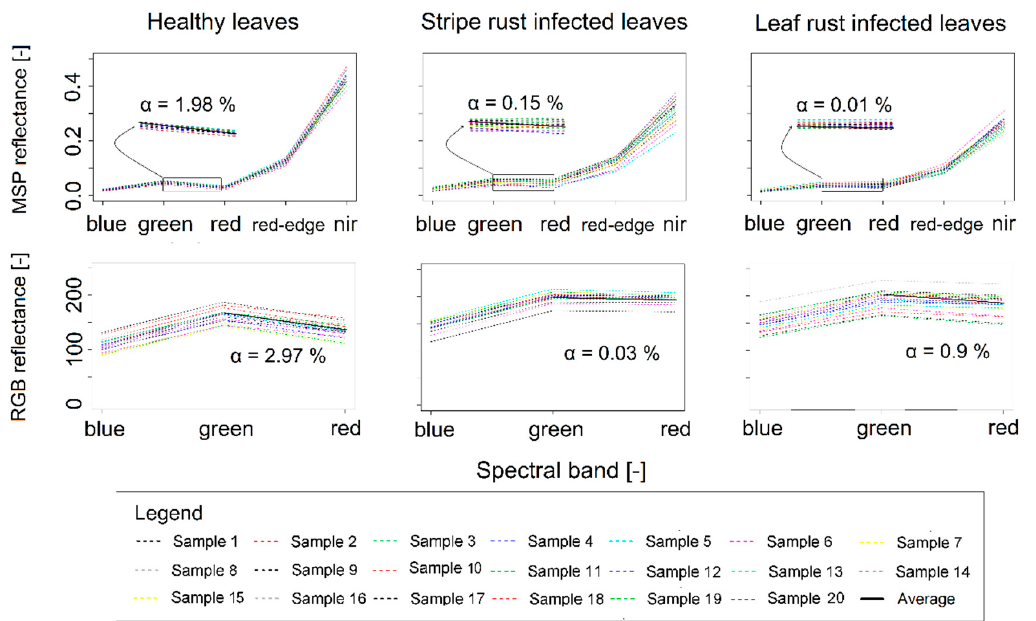
Figure 9. Reflectance spectra generated for healthy ( left ), stripe rust ( middle ), and wheat leaf rust ( right ) infected wheat samples derived from multispectral (MSP; top ) and Red-Green-Blue (RGB; bottom) sensors. Samples were selected according to the proposed stripe rust index (SRI) and leaf rust index (LRI) in this study. (Note the di ff erences in